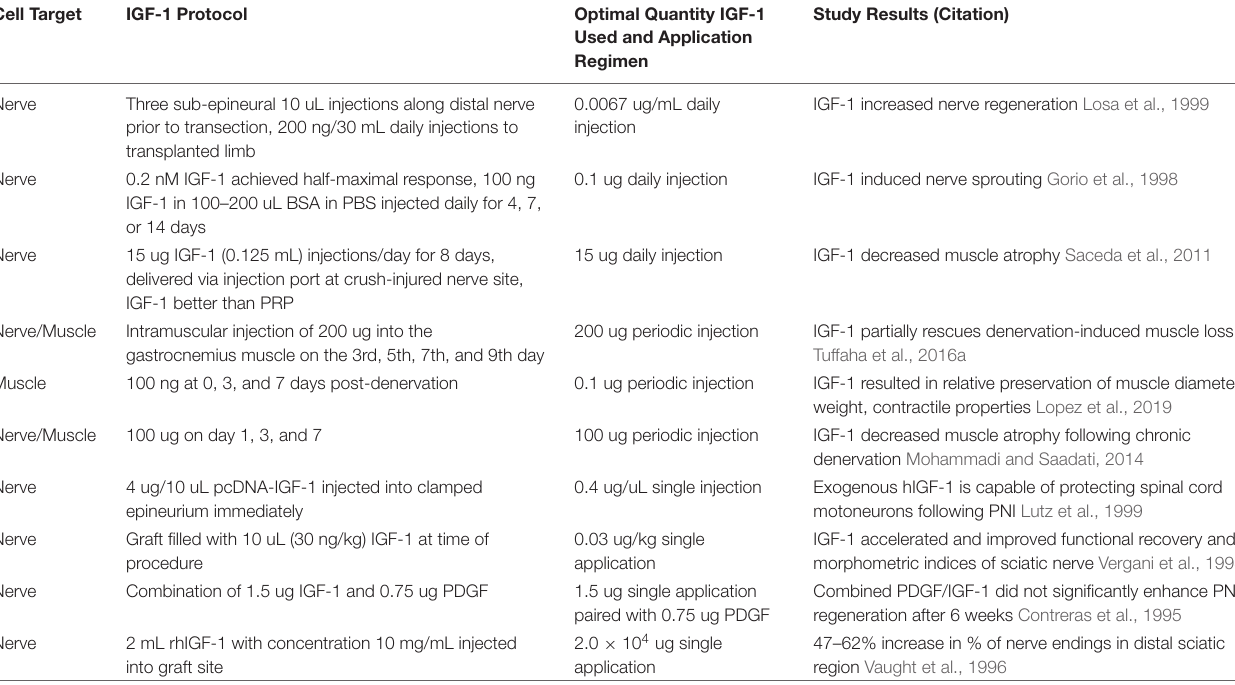
TABLE 4 | In vivo studies using targeted local application/injection of IGF-1 (BSA, bovine serum albumin; PBS, phosphate-buffered saline; PRP, platelet-rich plasma; pcDNA, plasmid-cloning DNA; hIGF1, human IGF-1; PNI, peripheral nerve injury; PDGF, platelet-derived growth factor). Cell Target